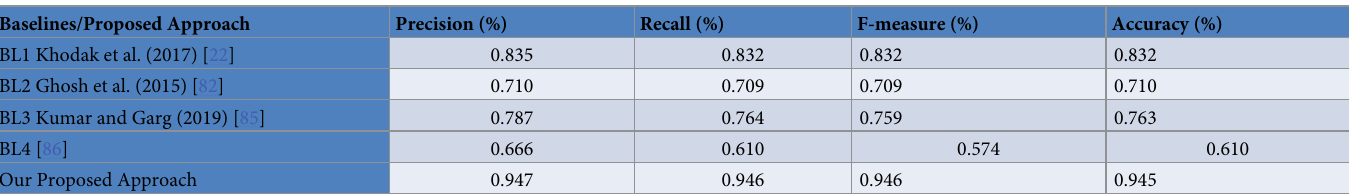
Table 12. Comparison of the proposed framework with baselines.